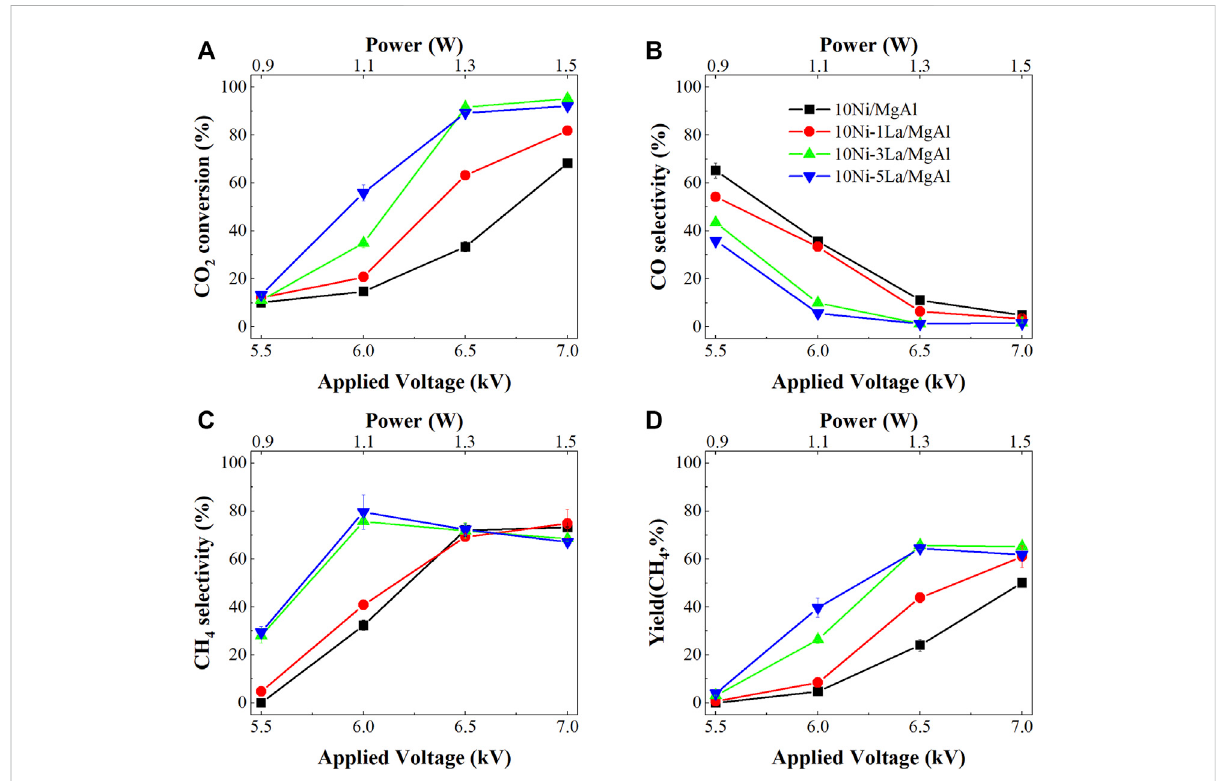
FIGURE 1 Performance of NTP-assisted CO 2 hydrogenation as a function of voltage over the 10Ni/MgAl system with different loadings of La; (A) CO 2 conversion, (B) CO selectivity, (C) CH 4 selectivity and (D) CH 4